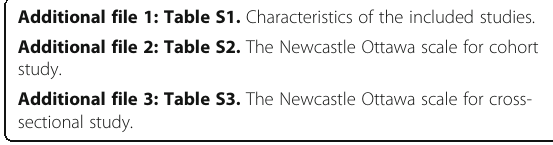
Additional file 1: Table S1. Characteristics of the included studies. Additional file 2: Table S2. The Newcastle Ottawa scale for cohort study. Additional file 3: Table S3. The Newcastle Ottawa scale for cross- sectional